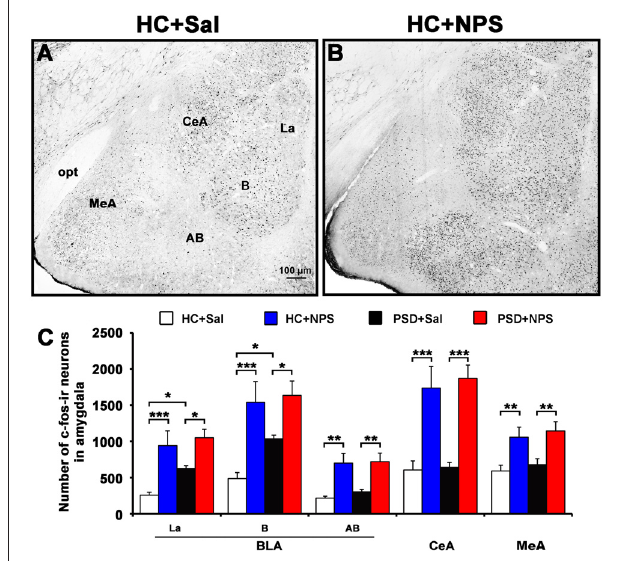
FIGURE 7 | Distribution of NPS-induced Fos immunoreactive (ir) neurons in the amygdala. Microphotographs representatively show Fos-ir neurons (black dots) in the amygdala in HC rats treated with saline (A) and NPS (B) . Histograms (C) show quantitative analysis of the number of For-ir neurons in the basolateral amygdala (BLA) including the lateral nucleus (La), basal nucleus (B) and accessory basal nucleus (AB), and the central amygdala (CeA) and medial amygdala (MeA) following saline ( n = 5) and NPS ( n = 5) i.c.v. injection to HC and PSD rats. Values are means ± SEM. ∗ P < 0.05, ∗∗ P < 0.01, ∗∗∗ P < 0.001. Data were analyzed by two-way ANOVA. Bar = 100 µ